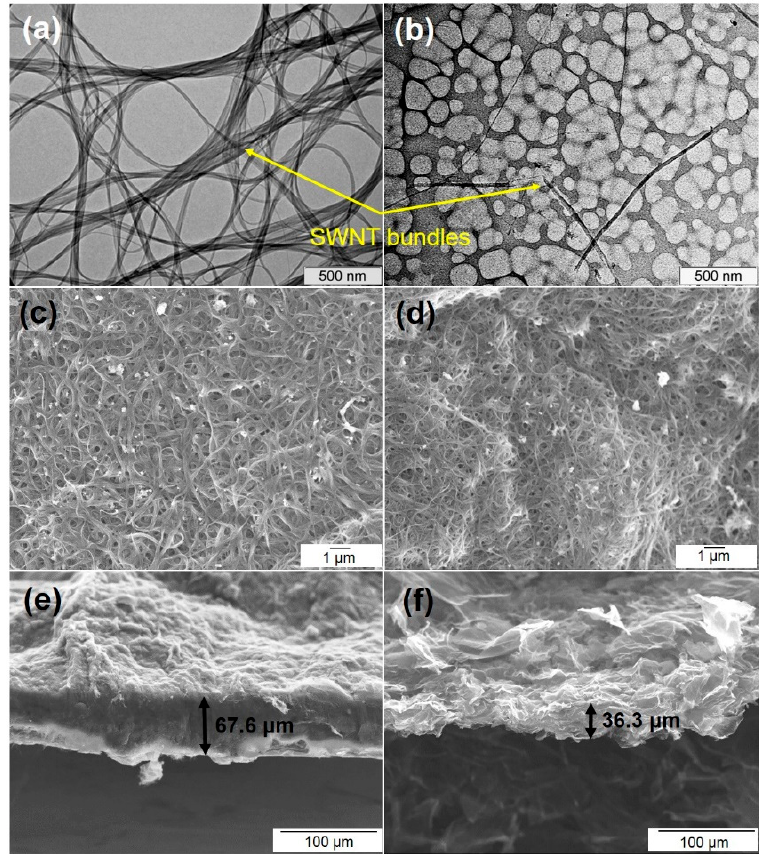
Figure 1. TEM images of purified SWCNTs before (sample SW, a ) and after (sample SW_DC, b ) the sonication in 1,2-dichlorobenzene and SEM images of top-view ( c , d ) and side-view ( e , f ) of the films prepared from sample SW ( c , e ) and sample SW_DC ( d , f ).